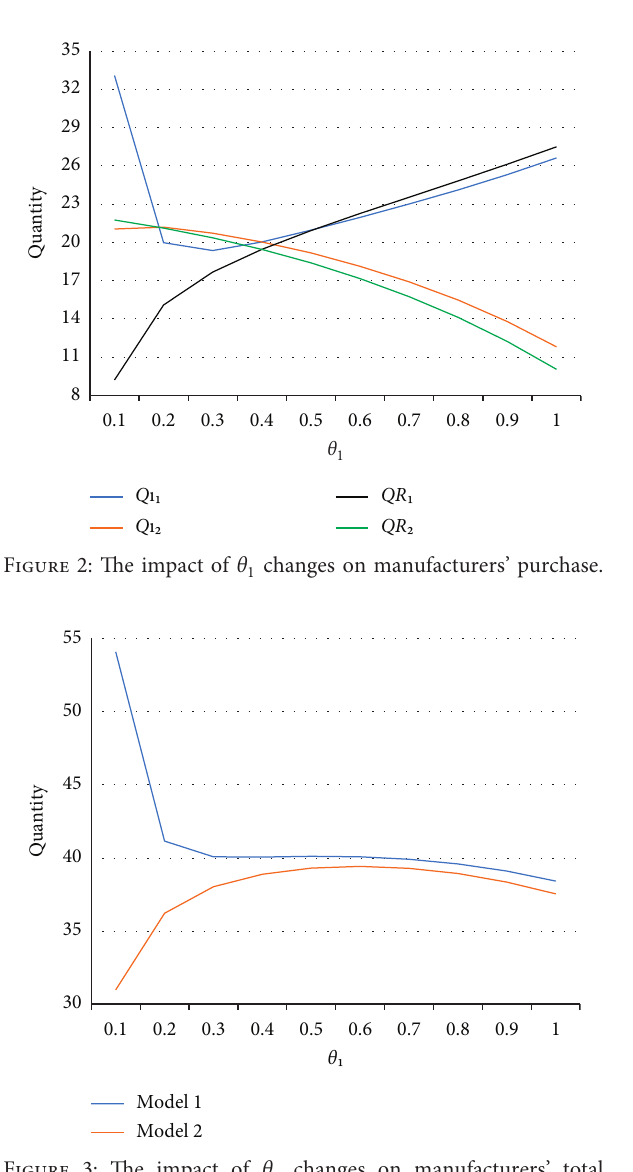
changes on manufacturers’ total 1